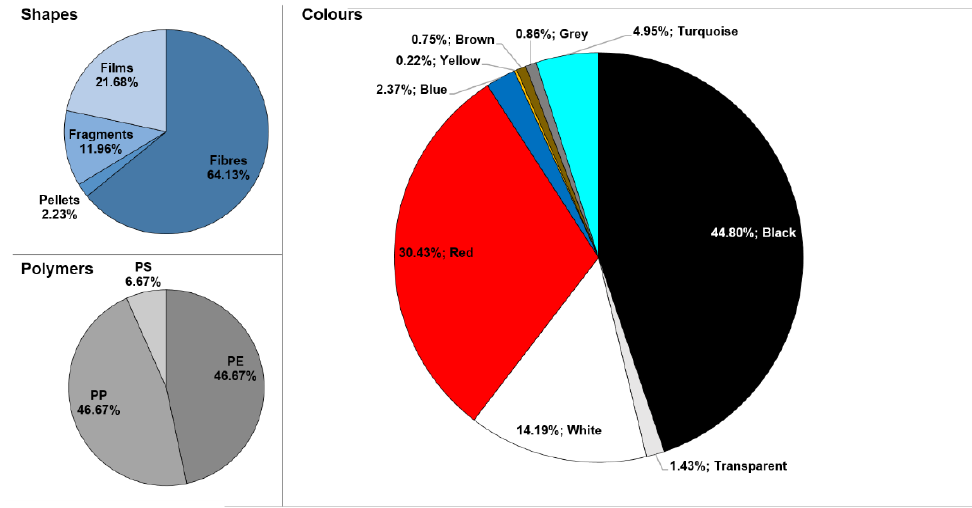
Figure 4. Percentages of shapes, colours and polymers of the identified MPs from all samples. Including the calculation formula, the concentrations of MP particles per litre were determined for each of the samples (cf. Figure 5).